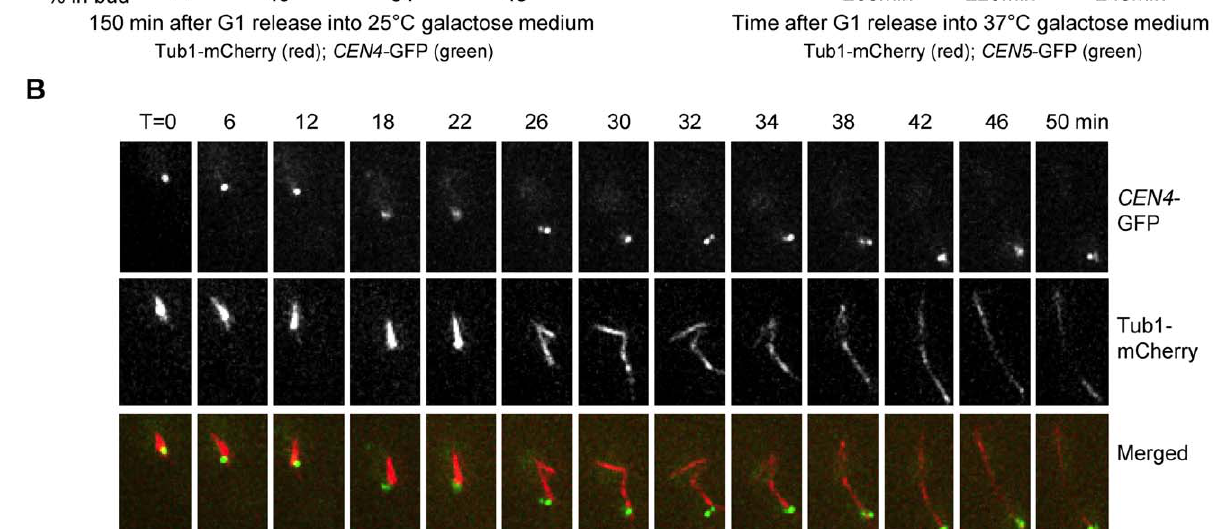
A temperature sensitive mutant kar 3- 64 shows chromosomes with syntelic attachment Overexpression of the coiled-coil domain of Cik1 may disrupt the function of other proteins with a coiled-coil domain, which could also contribute to syntelic attachments. To exclude this